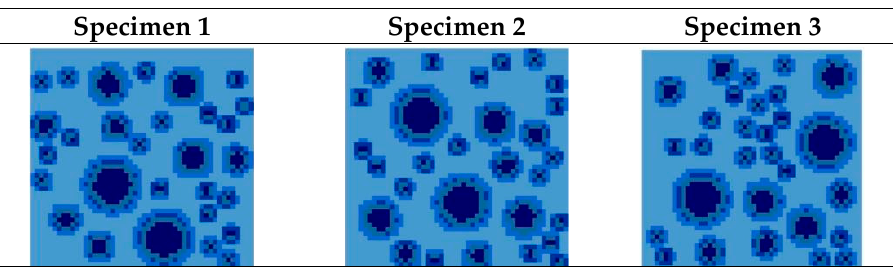
Figure 8. Two-dimensional diagram of homogenized model.